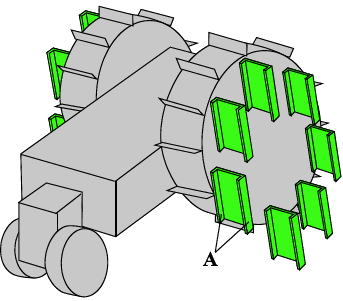
Figure 17. Channel shaped assistive grousers.